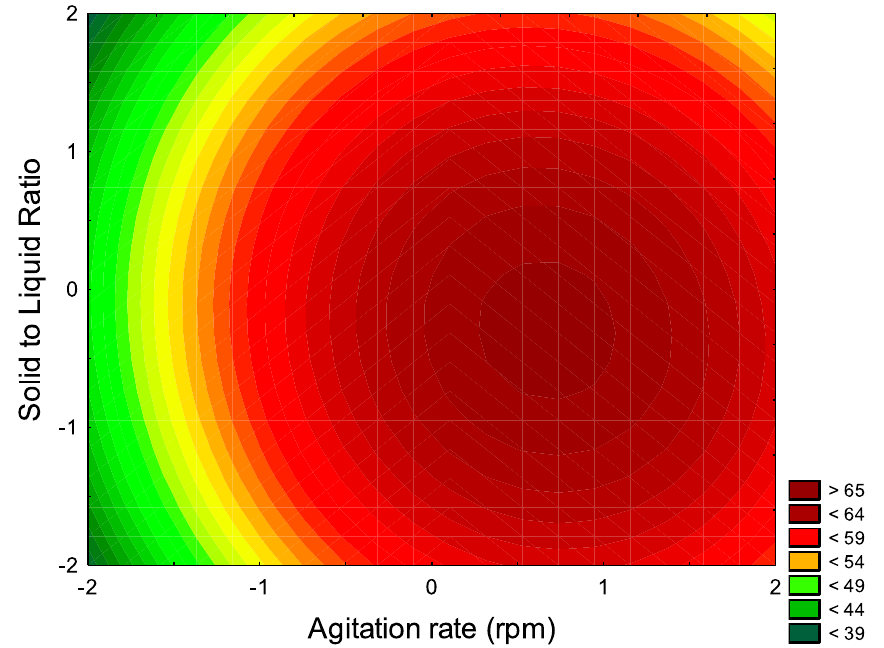
Figure 1. Response surface contour plot of OMSS yields for aqueous enzymatic extraction.